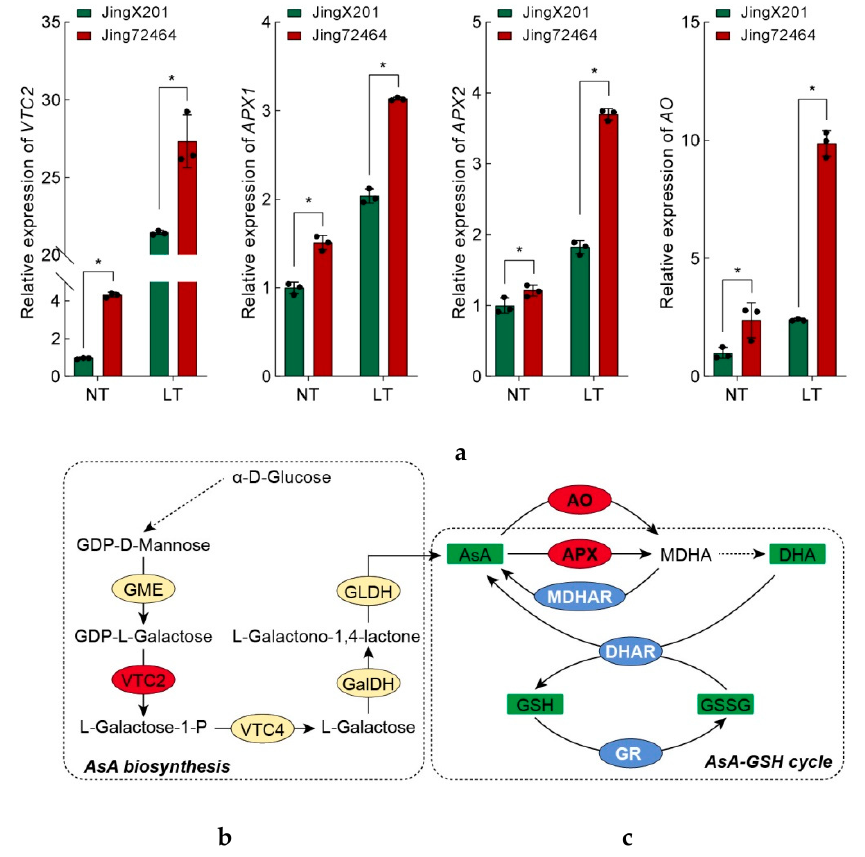
Figure 5. Transcription profile revealed the enhanced AsA biosynthesis and recycling in LT-tolerant inbred Jing72464. ( a , b ) Transcript levels of key enzymatic components in AsA biosynthesis ( a ) and AsA-GSH recycle pathway ( b ) in Jing72464 and JingX201. Transcription is measured relative to that of JingX201 seedlings under NT condition (set to 1). Data are mean ± s.e.m. ( n = 3), n.s. means no significance, * means p < 0.05. ( c ) Schematic representation of AsA biosynthesis and AsA-GSH recycle pathway.